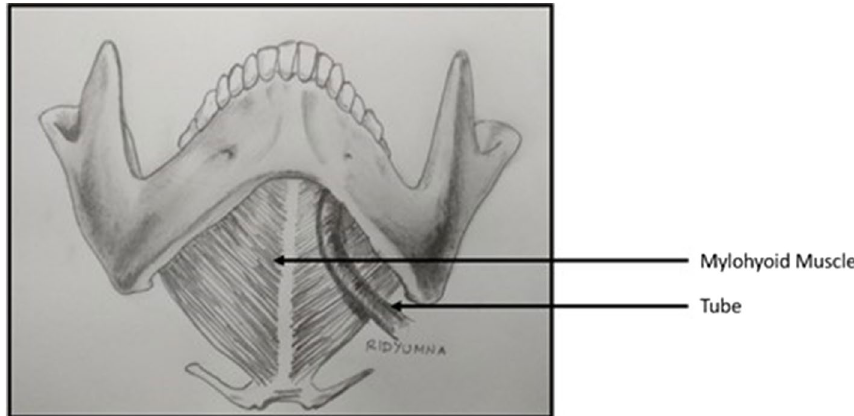
Fig. 6 Sketch demonstrating endotracheal tube passing through the attachment between the mylohyoid muscle and the medial surface of the mandible without penetrating the